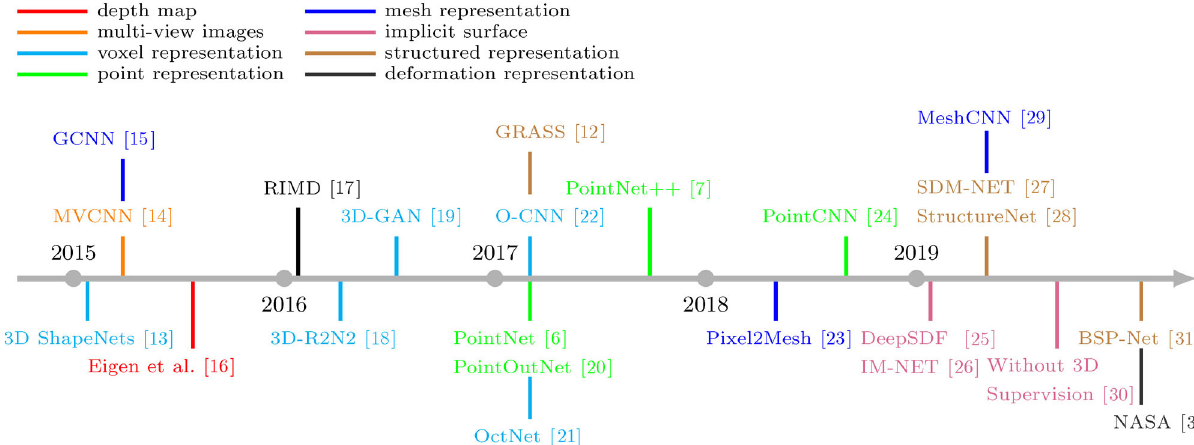
Fig. 1 The timeline of deep learning based methods for various 3D shape